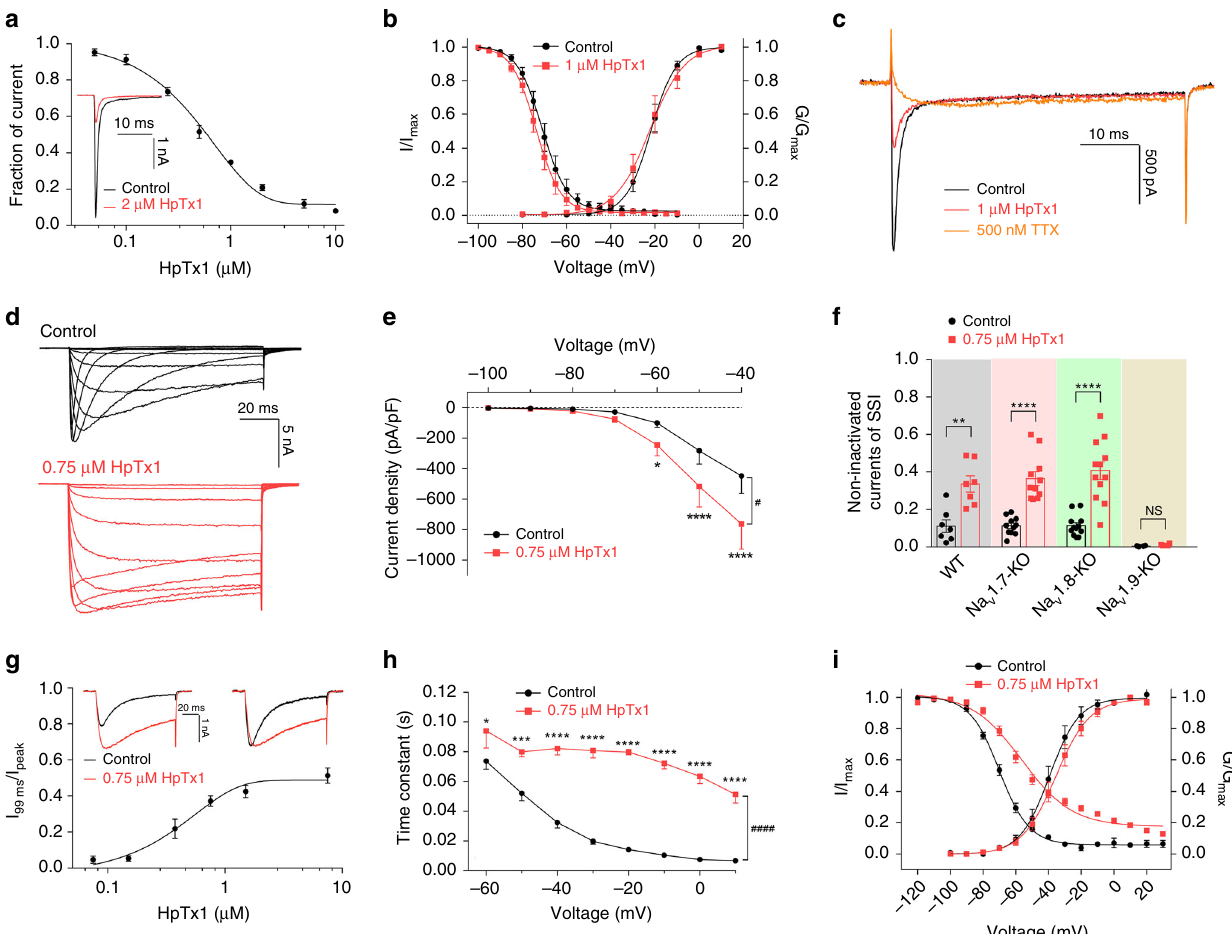
Fig. 3 HpTx1 inhibits Na v 1.7 currents and enhances Na v 1.9 activity. a The dose-dependent inhibition of hNa v 1.7 currents by HpTx1 ( n = 7). The inset shows representative current traces in the presence (red) or absence (black) of 2 μ M HpTx1. b Voltage-dependent steady-state activation (G/G max , n = 4) and fast inactivation (I/I max , n = 7) of hNa v 1.7 are not altered by 1 μ M HpTx1. c Representative currents show the effect of 1 μ M HpTx1 on TTX-S Na v s in mouse small DRG neurons. d , e HpTx1 increases TTX-R Na v currents in mouse small DRG neurons and inhibits their fast inactivation, as shown by representative current traces ( d ) and current density ( e , n = 6, two-way repeated measures ANOVA followed by Bonferroni ’ s multiple comparisons test, treatment × voltage: F (6,30) = 9.099, P < 0.0001; treatment: F (1,5) = 15.41, # P = 0.0111; voltage: F (6,30) = 16.25, P < 0.0001). f Bars show noninactivated components observed in the steady-state inactivation (SSI) curve (at − 20 mV) of multiple mouse TTX-R channels in the presence of 0.75 μ M HpTx1 (unpaired two-tailed t test, WT mice: t 12 = 4.09, P = 0.0015, n = 7; Na v 1.7-KO mice: t 20 = 6.447, P < 0.00001, n = 11; Na v 1.8-KO mice: t 22 = 5.905, P < 0.00001, n = 12; Nav1.9-KO mice: t 6 = 1.999, P = 0.0925, n = 4). Note that 1 μ M TTX was applied in these experiments ( d – f ). g The dose – response curves for the HpTx1-induced inhibition of the fast inactivation of hNa v 1.9 expressed in ND7/23 cells ( n = 5). The inset shows representative current traces (left) and normalized current traces (right) in the absence (black) and presence of 0.75 μ M HpTx1 (red). h HpTx1 signi fi cantly slows the fast inactivation time of hNa v 1.9 ( n = 6 for control, n = 5 for HpTx1, two-way ANOVA followed by Bonferroni ’ s multiple comparisons test, treatment × voltage: F (7,66) = 6.386, P < 0.0001; treatment: F (7,66) = 27.35, #### P < 0.0001; voltage: F (1,66) = 411.9, P < 0.0001). i Voltage dependence of the steady-state activation (G/G max ) and